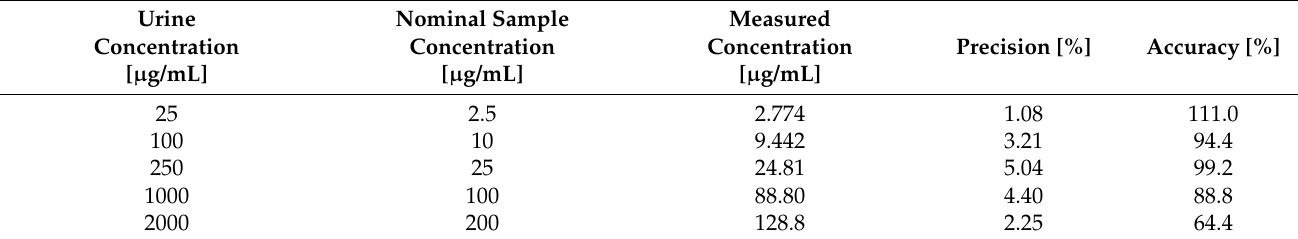
Table 3. Inter-day precision and accuracy of lysozyme measurement in human urine using the Lys-PMNPs ( n = 3). Urine